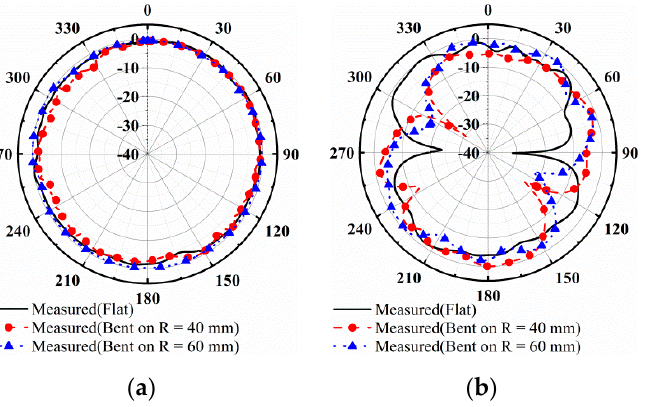
Figure 9. Measured radiation patterns under the flat and bending states. ( a ) x – z plane. ( b ) x – y plane.